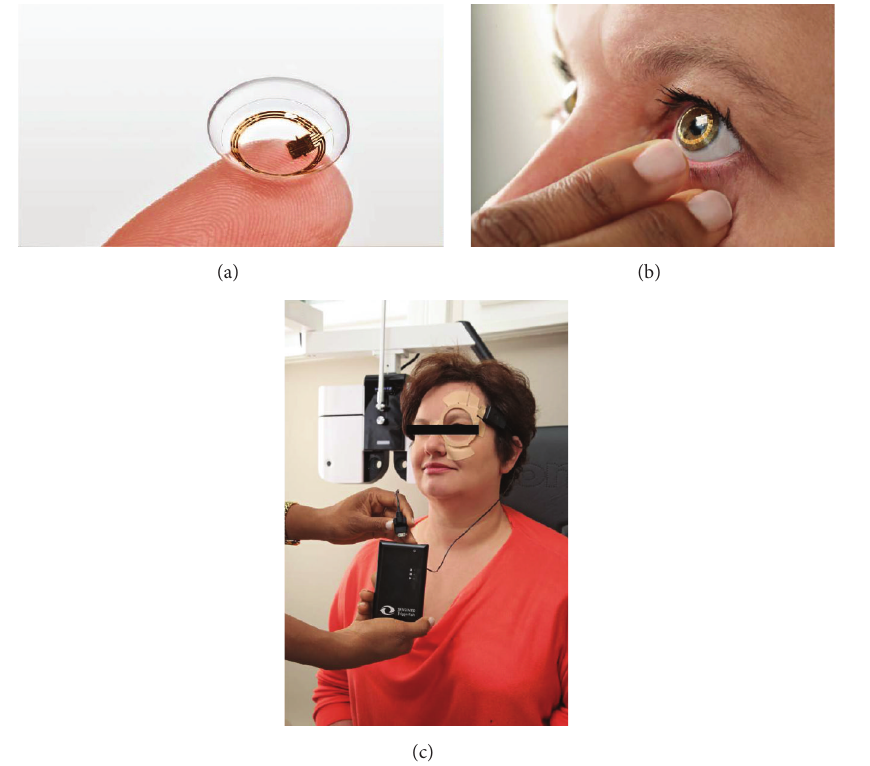
Figure 1: (a) SENSIMED Triggerfish contact lens sensor. (b) The contact lens sensor worn on the eye. (c) The device system consists of a wireless contact lens sensor, a periorbital antenna, data cable, and a recorder. Images are reproduced from SENSIMED Triggerfish with permission from the